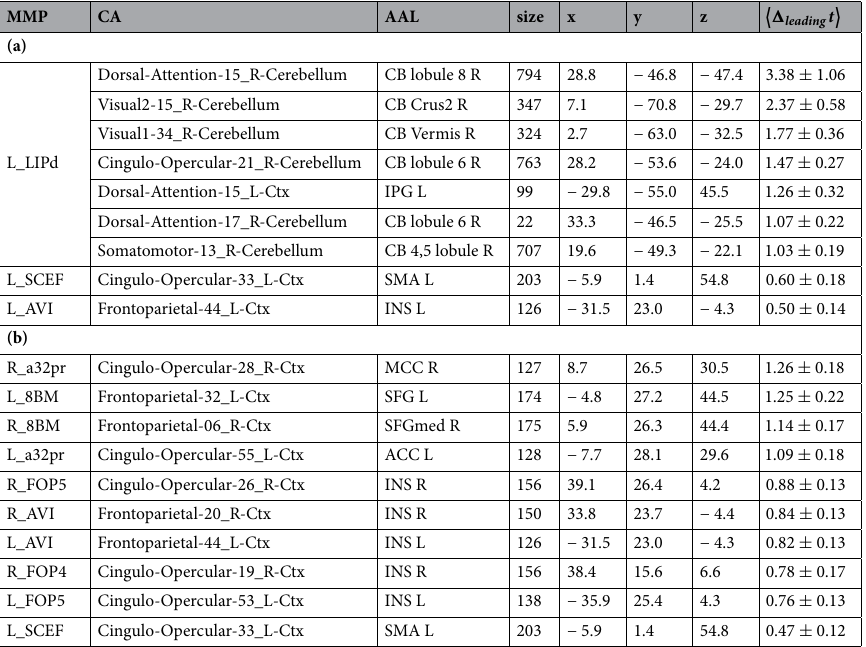
Table 1. ( a ) Regions in the MMP/CA parcellation with significant leading delayed responses between POScorr and LURfalse. AAL indicates the AAL region where the centre of mass of the MMP/CA region is located. The MNI coordinates x , y , z of the centre of mass of each region are evaluated as an average over the region coordinates for each subject, as the surface-based cortical data is sensitive to the individual cortical folding patterns. size is the number of grayordinates for each region, i.e., voxels for subcortical and vertices for the cortical ones. (cid:31) (cid:31) leading t (cid:30) is the average leading time delay (see “Methods” for the definition) between POScorr and LURfalse activations, expressed in units of TR. The errors are estimated by bootstrap. CB cerebellum, INS insula, IPG inferior parietal gyrus, SMA supplementary motor area, L left hemisphere, R right hemisphere. ( b ) Regions in the MMP/CA parcellation with significant trailing delayed responses between POScorr and LURfalse. The columns are as in Table (a) apart from (cid:31) (cid:31) trailing t (cid:30) , which is the average trailing time delay (see “Methods” for the definition) between POScorr and LURfalse activations, expressed in units of TR. The errors are estimated by bootstrap. ACC anterior cingulate cortex, INS insula, MCC middle cingulate cortex, SFGmed superior frontal gyrus medial part, SMA supplementary motor area, L left hemisphere, R right hemisphere.